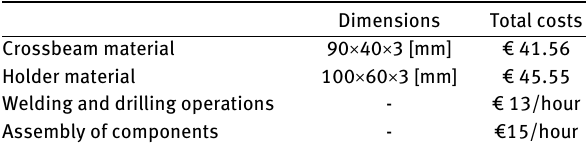
Table 4: Costs of